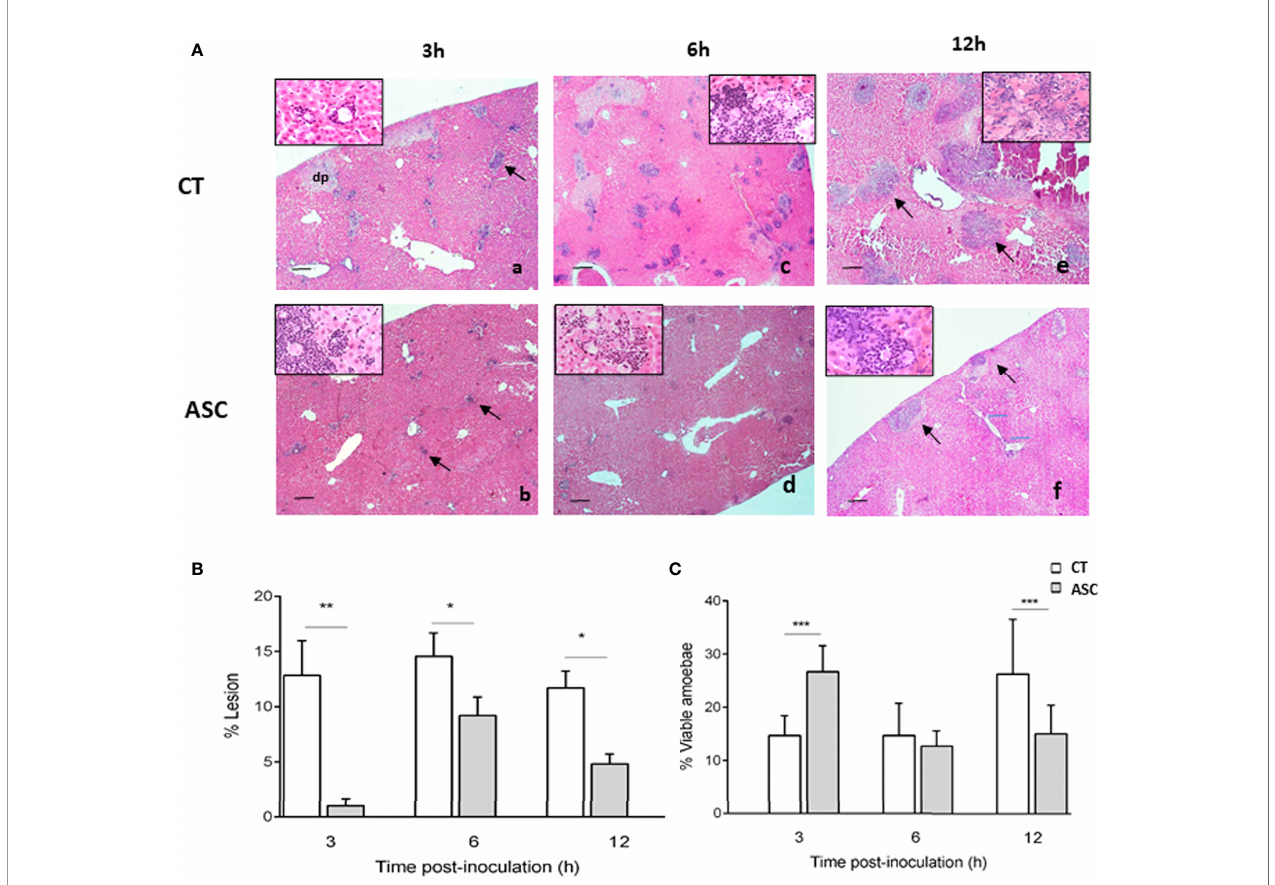
FIGURE 1 | (A) Histological analysis of hamsters inoculated with amoebae and treated (Ab, Ad, Af) or not with ASC (Aa, Ac, Ae). (Aa) ALA in fl ammatory in fi ltrate (arrow) and area of damaged parenchyma and the presence of damaged amoebae (inserted box). (Ab) Animals treated with ASC showed in fl ammatory foci (arrows) with the presence of amoebae (inserted box). (Ac) ALA 6 h, presence of trophozoites (inserted box). (Ad) Animals treated with ASC showed in fl ammatory foci and amoebae (inserted box). (Ae) ALA 12 h large necrotic area with the presence of amoebae (inserted box) and in fl ammatory cells (arrows). (Af) Animals treated with ASC at 12 h showed less damage to the parenchyma and in fl ammatory in fi ltration (arrows) and damaged amoebae (inserted box). Bar = 200 m m. The liver was removed and weighed to determine the percentage (%) of liver damage in ALA using the following formula: % ALA = (abscess weight/total liver weight) × 100. The percentage of ALA was signi fi cantly diminished at 3, 6, and 12 h p.i. in hamsters treated with ASC compared with CT hamsters (B) . The percentage of viable amoebae was higher in the ASC group at 3 h, similar in the two groups at 6 h and decreased in the ASC group at 12 h (C) . ***p < 0.001, **p < 0.01, *p <